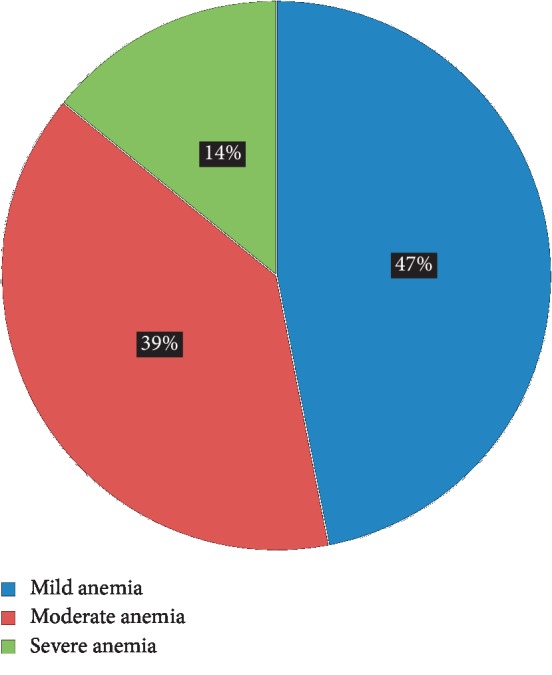
Hgb classification of the participants from the DBRH ART clinic who were on HAART.